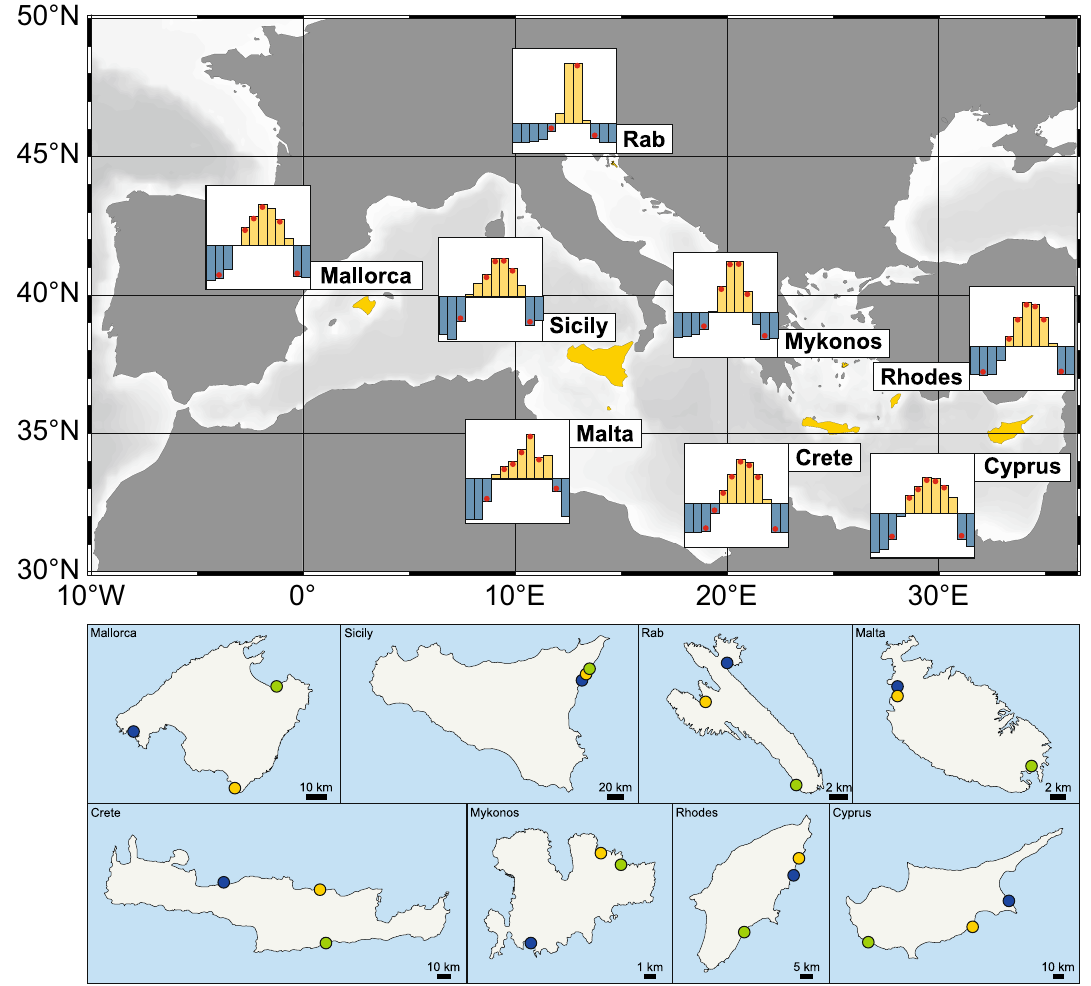
Figure 1. General map of the Mediterranean Sea. Top: the 8 islands selected for this study. The graphic next to each island shows the normalized monthly number of tourists (Y axis, arbitrary scale) welcome in 2016 or 2017 (X-axis, from January to December) (Supplementary Table S1). Yellow bars: high touristic season (monthly number of tourists above the annual average), blue bars: low touristic season (monthly number of tourists below the annual average). Red dots: marine litter surveys. Below: map of each island with the selected beaches (T beach : yellow dots, L beach : blue dots and R beach : green dots). The general map of the Mediterranean Sea was generated with Ocean Data View (Schlitzer, R., Ocean Data View, https ://www.awi-breme rhave n.de/GEO/ODV,